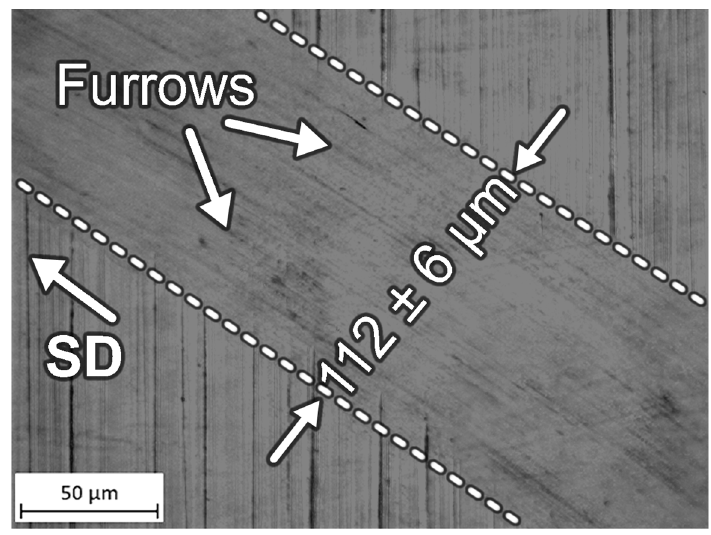
Figure A3. Optical micrograph of worn surface of the AISI 8620 ball tested with mineral oil.